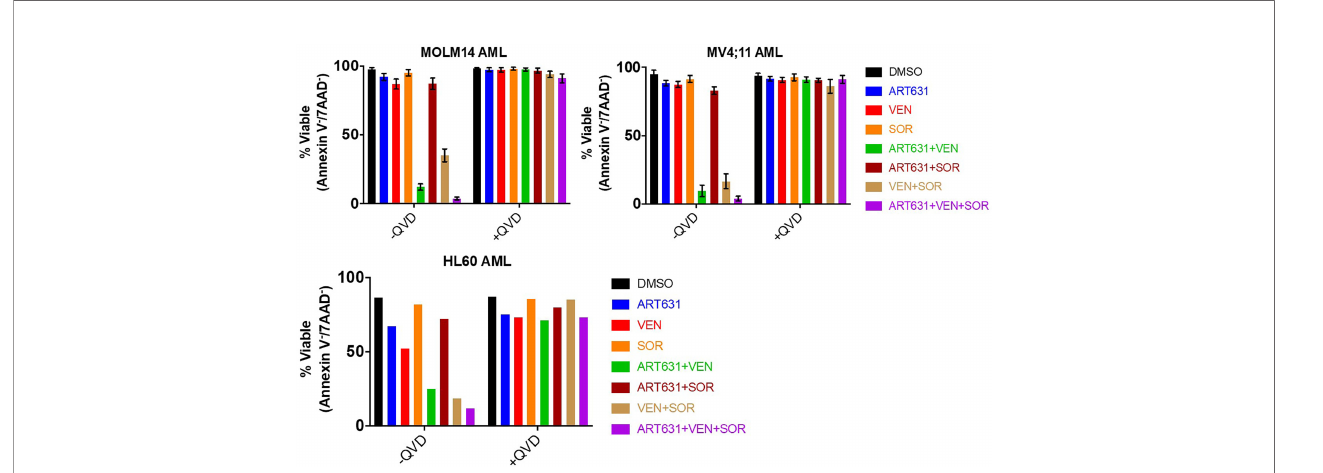
FIGURE 3 | ART631-based combination treatments reduced cell viability in AML cell lines. MOLM14, MV4;11, and HL60 AML cells were each treated for 18h with vehicle (DMSO) control, ART631 alone (200 nM), VEN alone (50 nM), SOR alone (5 uM), and 2- and 3-drug combinations, all with and without a 30-45 min pre- incubation with 10 nM pan-caspase inhibitor QVD-OPh (QVD). Treatedcellswere stained with 2.5 ug/mL7-aminoactinomycin D (7-AAD) and 0.5 ug/mLallophycocyanin (APC)-conjugated Annexin V in Annexin V binding buffer andanalyzedby fl ow cytometry. Graphs indicate % cellviability based on Annexin V/7-AADdual staining. For MOLM14 and MV4;11, meansand SDsshown are basedon3 independent experiments. HL60 celldatais fromone experiment done in